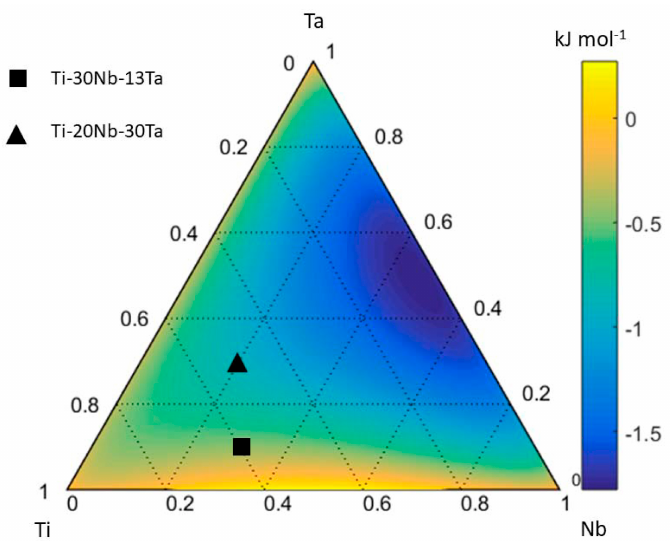
Figure 11. Ternary diagram of Gibbs’ free energy for the Ti − Nb − Ta system at 298 K (reproduced with permission [67]).